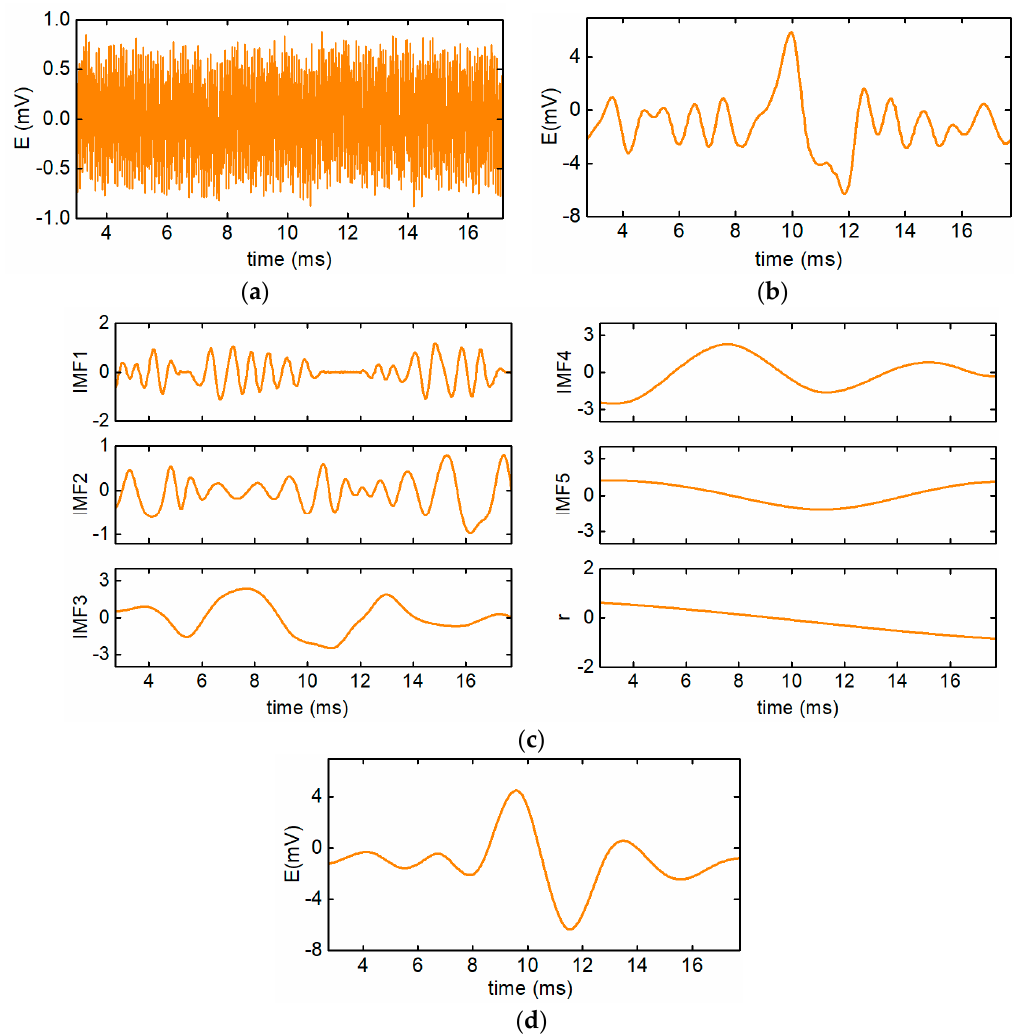
Figure 7. The simulation of the signal extraction process. ( a ) The raw signal of the sensor, ( b ) the preliminarily extracted particle signal, ( c ) the decomposed particle signal, and ( d ) the shaped particle signal.